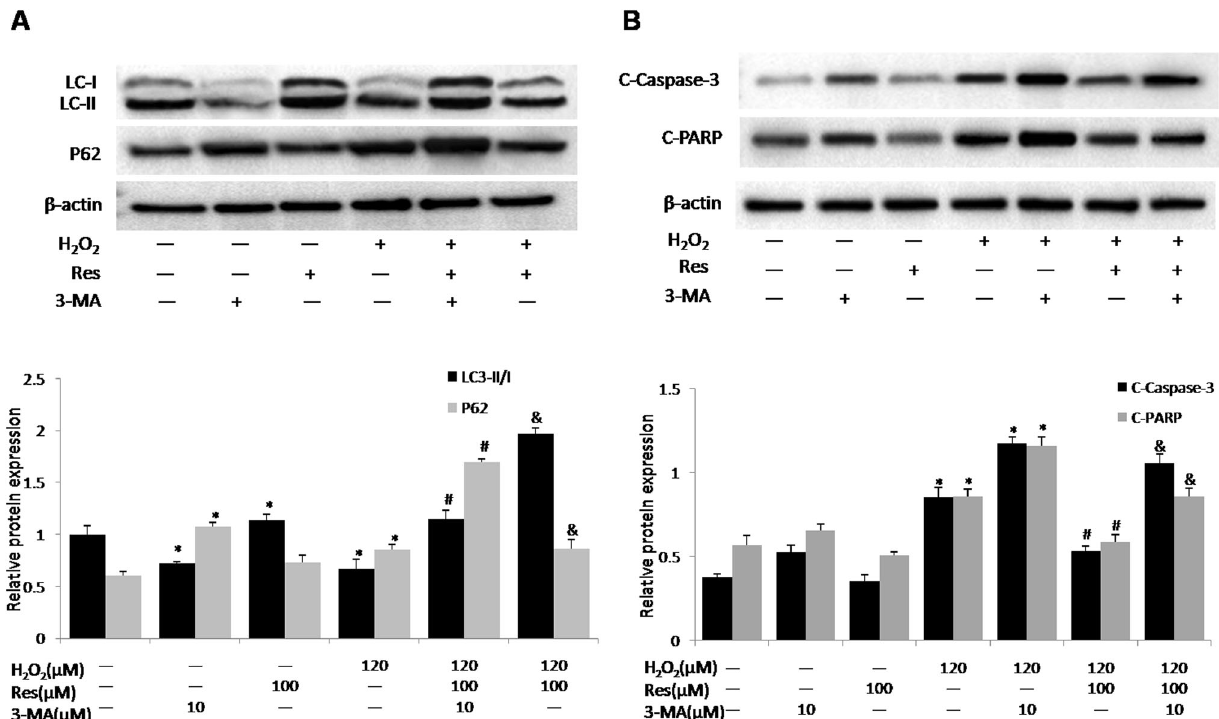
Fig. 3 Resveratrol attenuates H 2 O 2 -induced apoptosis associated with enhanced autophagy. MLO-Y4 cells were pretreated with 3-methyladenine (3-MA, 10 μ M) for 30 min before exposure to H 2 O 2 (120 μ M) and resveratrol (Res, 100 μ M) for 14 d. A The protein expression of LC3-II/I and P62 in cell lysates were detected by western blotting. B Apoptosis markers including cleaved caspase-3 (C-caspase-3) and cleaved PARP (C-PARP) in cell lysates were detected by western blotting. n = 3; # P < 0.05 vs. control, * P < 0.05 vs . H 2 O 2 , & P < 0.05 vs. H 2 O 2